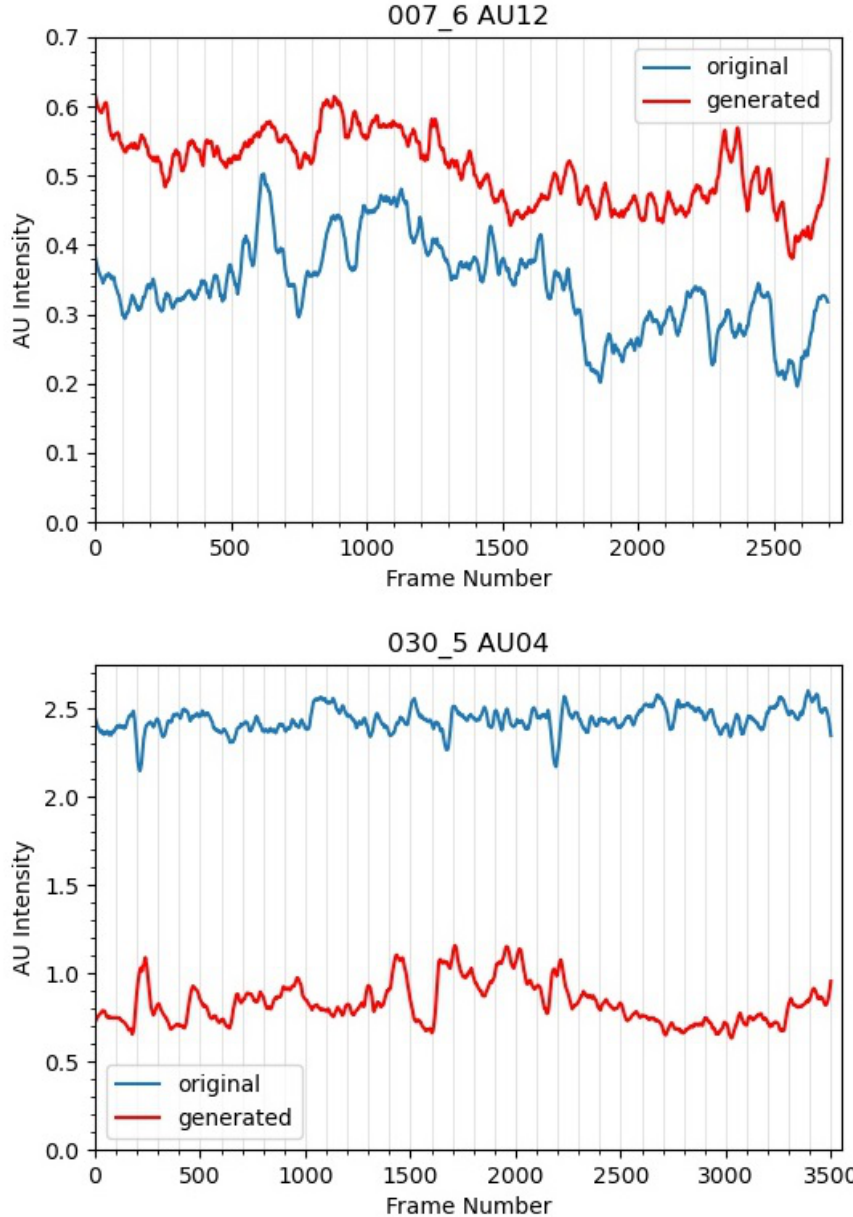
Figure 3. Illustration of AU intensities measured by OpenFace for selected videos of 007_6 and 030_5 of SAMM-LV and SAMM-SYNTH. AU12 is amplified, while AU4 is softened in the synthetic data. According to OpenFace’s documentation, AU intensity has a range of 0 (not present) to 5 (maximum intensity). However, the AU intensity is standardised based on the initial frame. The changes in AU intensities indicate movements of that AU which is what we are interested